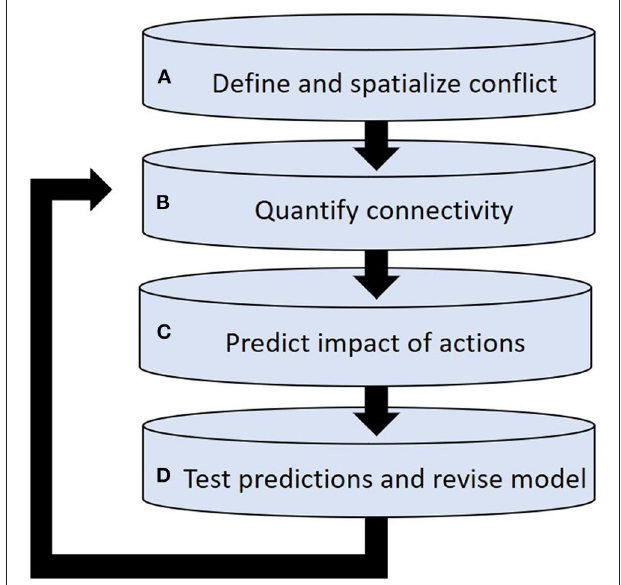
FIGURE 1 | Conceptual framework of adaptive management proposed to mitigate human-wildlife conflicts based on four steps: (A) define and spatialize conflict areas by considering social tolerance and negative interactions between human and wildlife at local scale; (B) predict animal distribution from empirical models of functional connectivity and patch residency time; (C) use advection-diffusion equations developed from functional connectivity models to predict the impact of management actions on animal distribution; and (D) test predictions in the field and revise the model as more information become